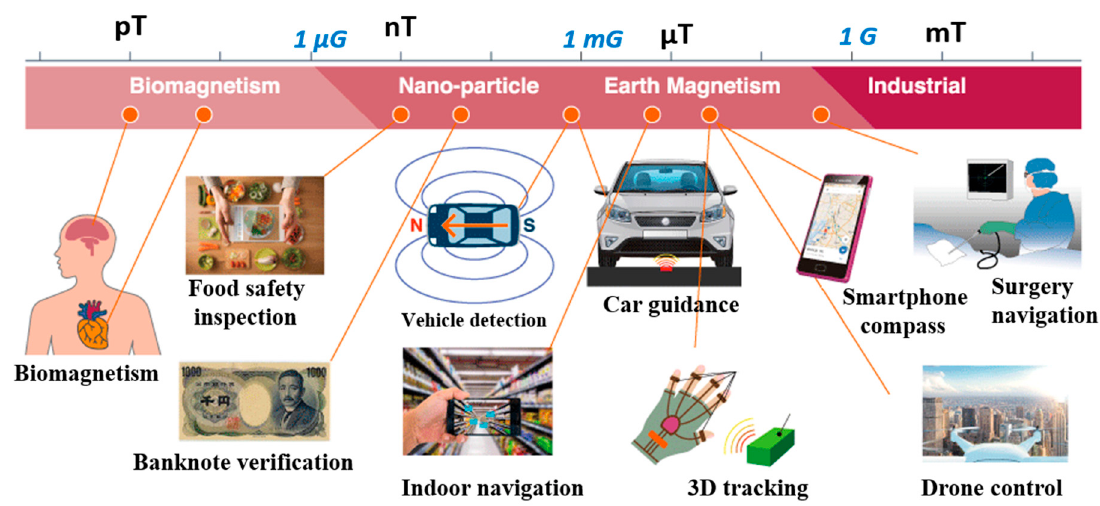
Figure 2. The potential applications of MI sensors proposed by Aichi Micro Intelligent Corporation. Reprinted with permission from Ref. [23]. Copyright 2022 Aichi Steel Corporation.